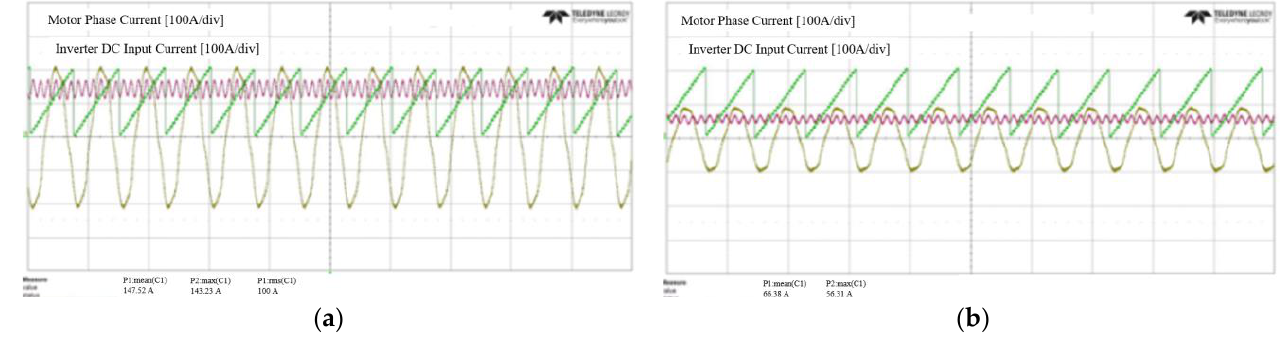
Figure 25. Current test waveforms for the final model: ( a ) current waveform when it was operating the motor at maximum output; ( b ) current waveform when it was operating the motor at maximum efficiency. Table 4. Maximum output test result of the final model.